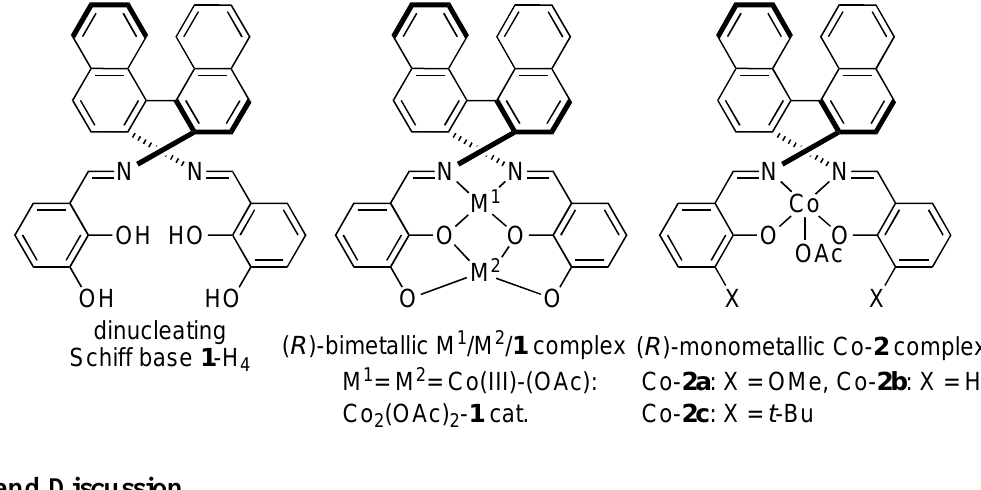
, bimetallic M 1 /M 2 Schiff 4